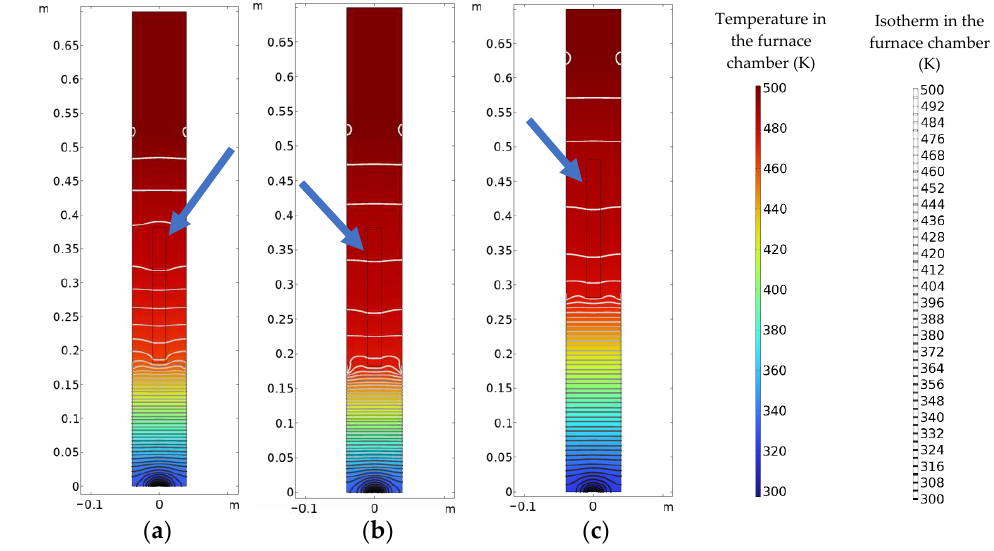
Figure 7. Temperature field distribution at 250,000 s in Bridgman furnace: ( a ) process A; ( b ) process B; ( c ) process C.